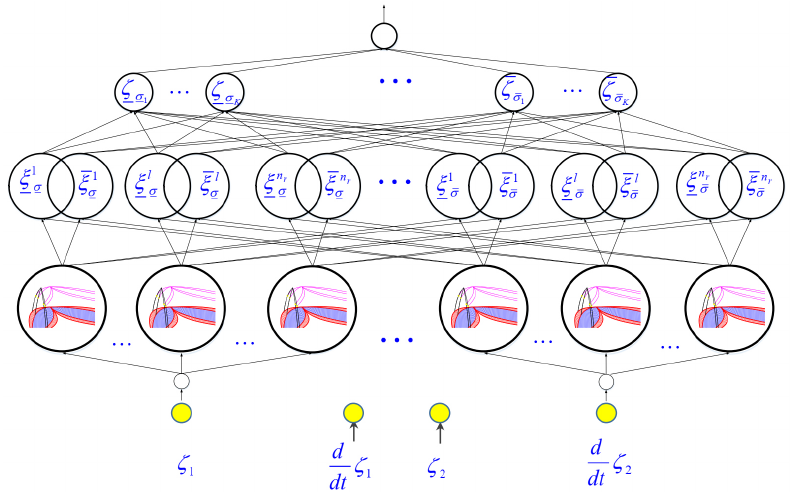
Figure 3. The main diagram of